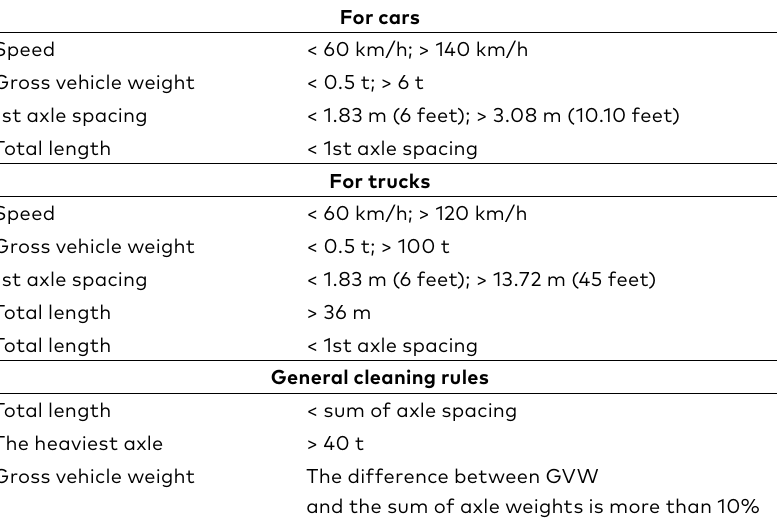
Table 1. Filtering criteria to identify records with likely errors For